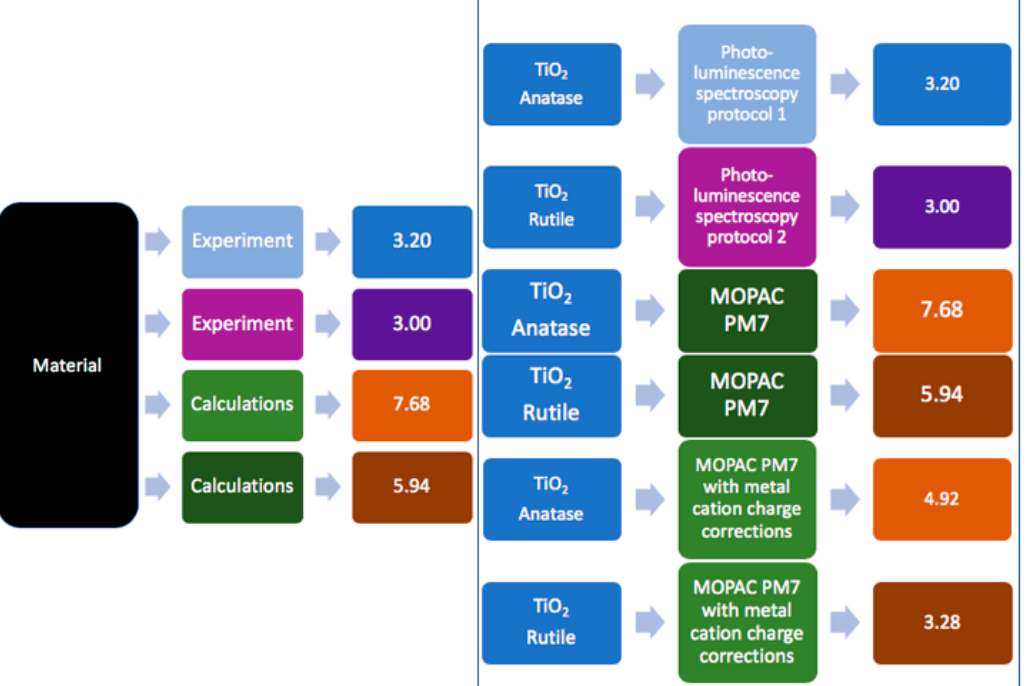
Figure 7. Integrating data points without paying attention to the metadata (left), provides little information, while a careful examination of metadata reveals the independent variables influencing experimental and computational results, allowing insights into how they came to be and a more informed choice on which values to accept and